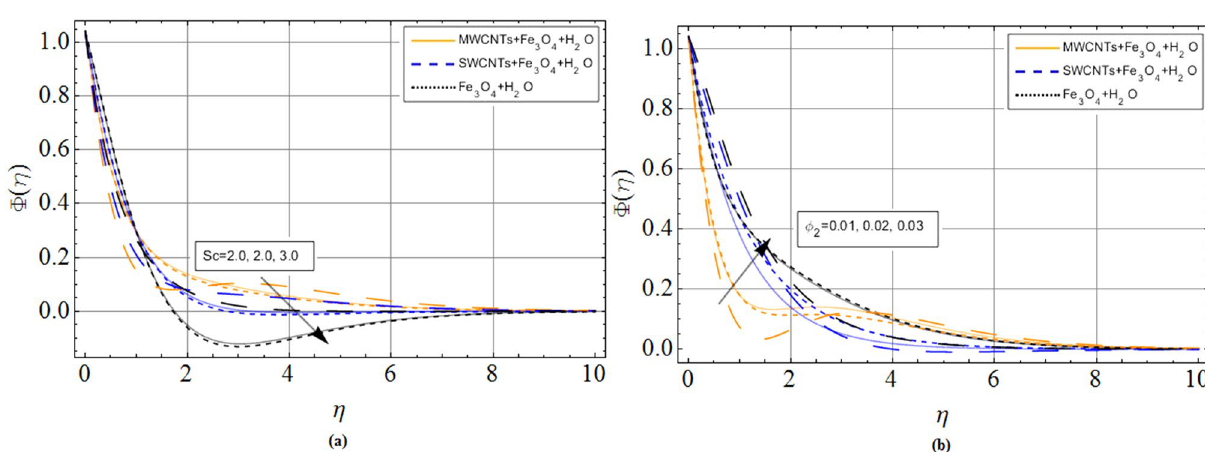
Figure 7. ( a ) Schmidt number Sc effects on concentration profile �(η) ( b ) volume friction parameter effects concentration profile �(η) . When φ 1 = 0.01, Pr = 6.2, M = 1.0, N =